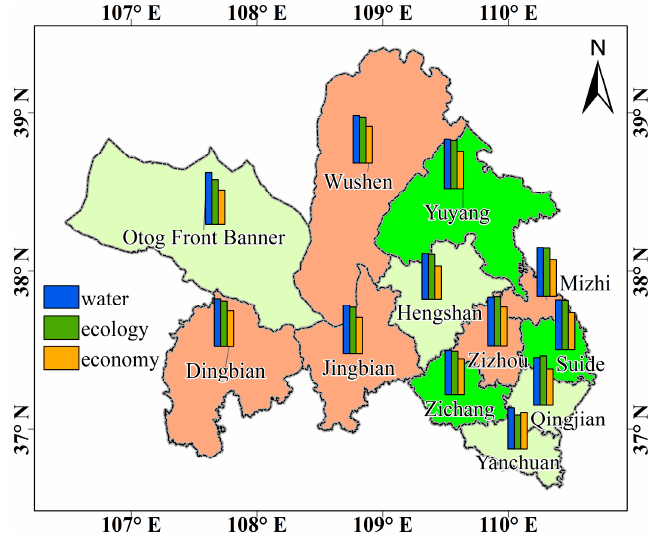
Figure 7. Histogram showing grey correlation of the water, ecology and economy subsystem evaluation indices with the water–ecology–economy coordinated degree. The background color of each county is the same as in Figure 4d.